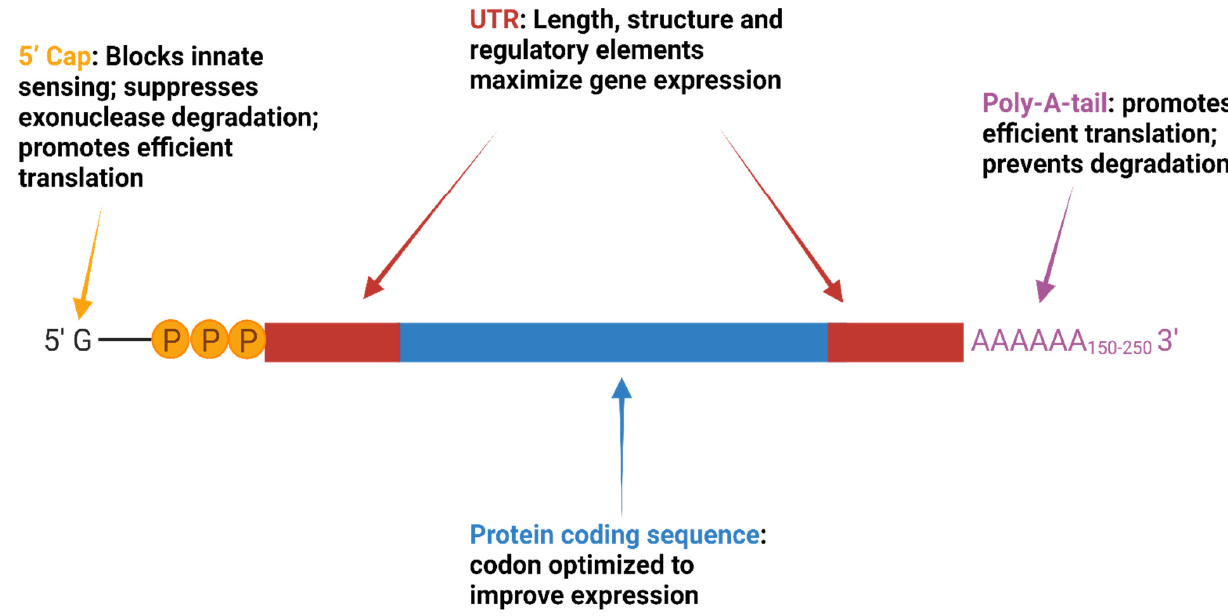
Figure 1. mRNA vaccine/therapeutic protein construct.